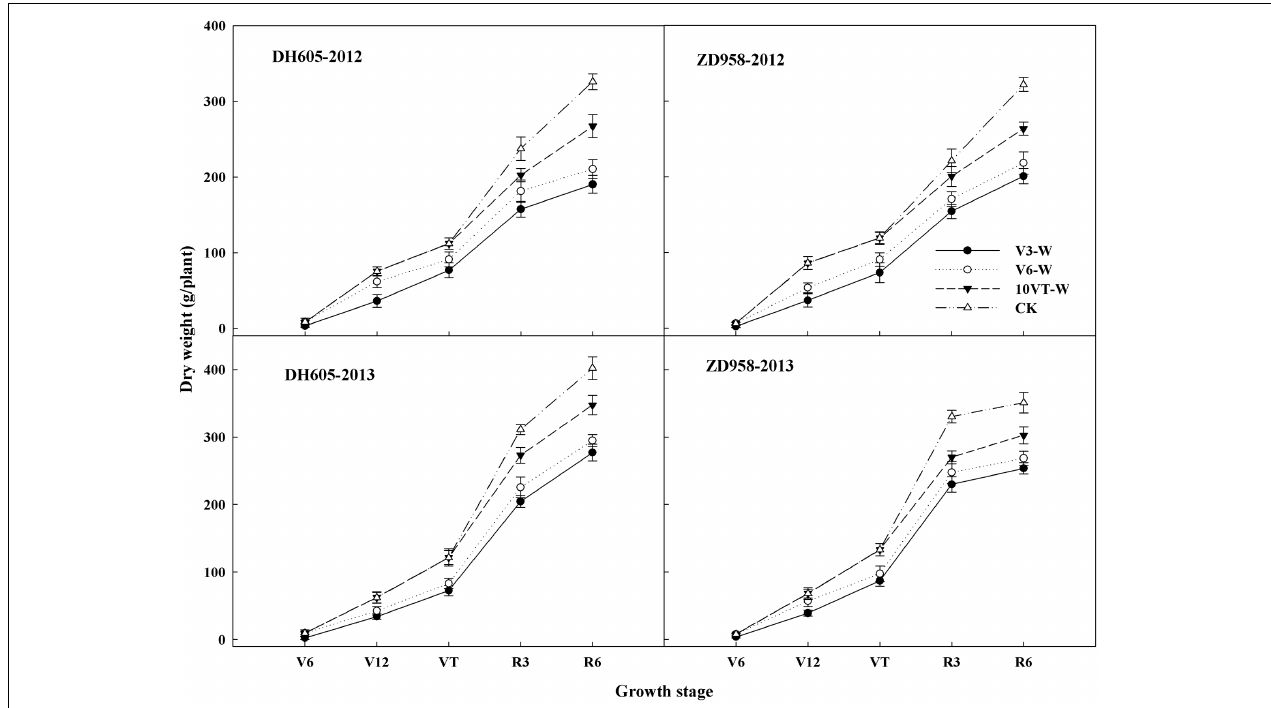
FIGURE 2 | Effects of waterlogging on dry matter accumulation of maize. V3-W: waterlogging at the third leaf stage; V6-W: waterlogging at the sixth leaf stage; 10VT-W: waterlogging at 10th day after the tasseling stage. Means and standard errors based on three replicates are